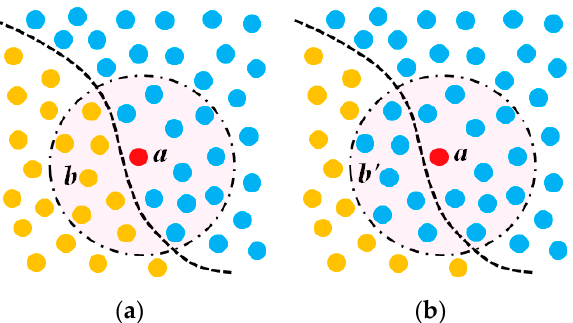
Figure 2. Treatment on the interface of different fluids: ( a ) original particles; ( b ) converted particles. As shown in Figure 2a, a is the central particle (in red) and b represents the neighboring particles of the other phase (in yellow). In this model, particle b is converted into particle b’ (in blue) of the same phase with particle a , as shown in Figure 2b, which occupies the same position, velocity, and volume as the original particle b . Only the position, volume, velocity, and pressure of these neighboring particles are taken into account in particle